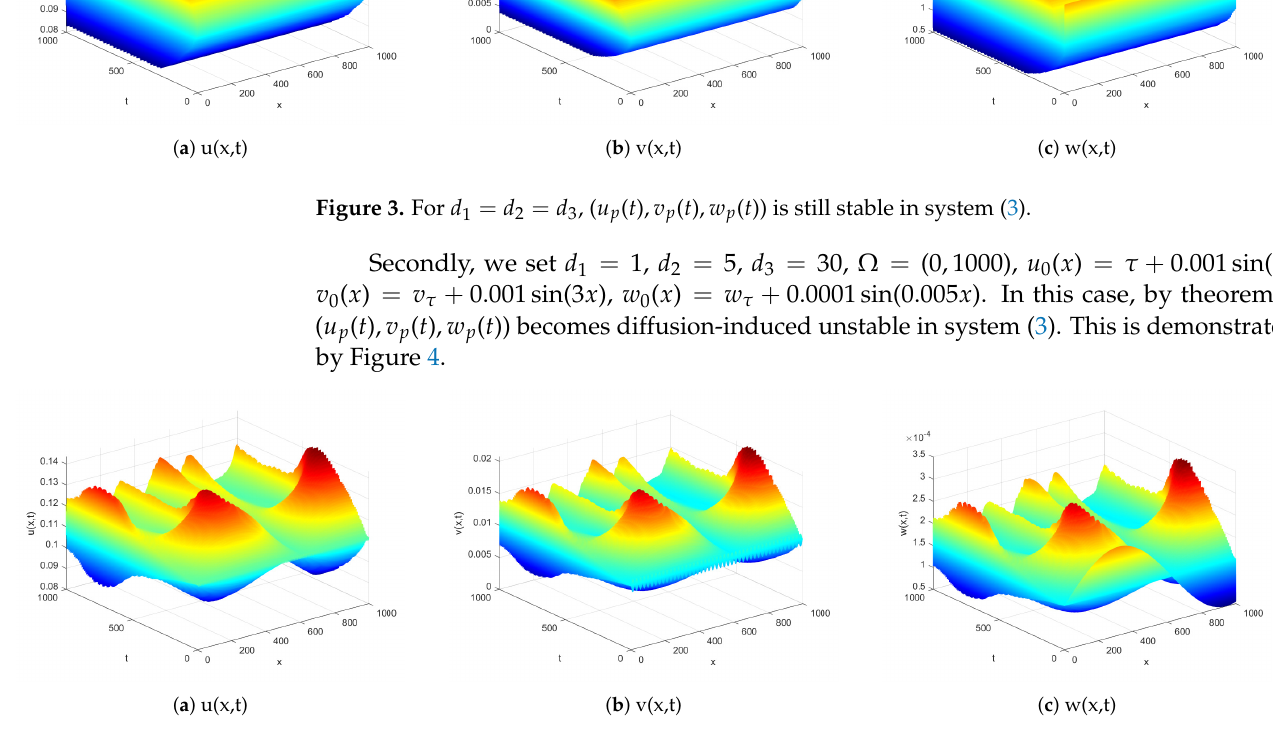
Figure 4. ( u p ( t ), v p ( t ), w p ( t )) becomes diffusion-induced unstable, and the emerging spatiotemporal patterns can be